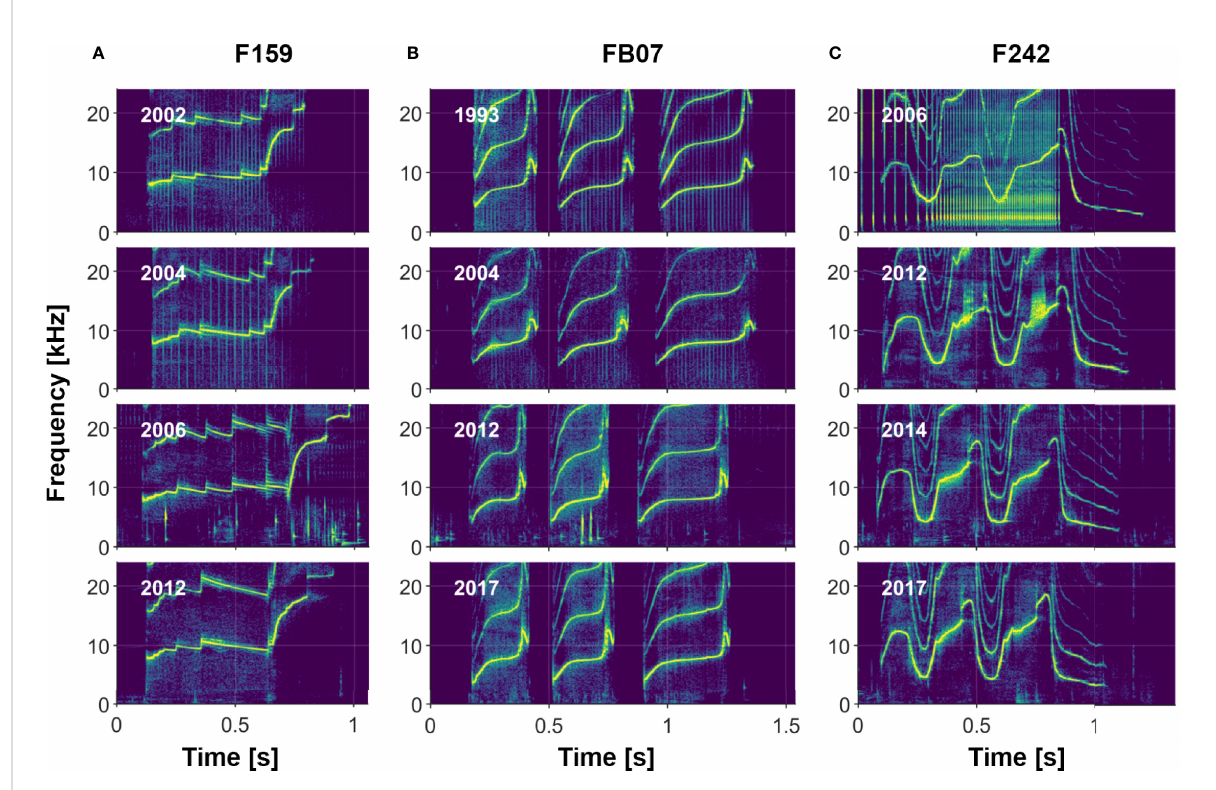
FIGURE 8 Three examples of individuals recorded across 10 or more years, illustrating signature whistle stability. (A) Female F159, who produces a single-loop whistle; (B) Female FB07, who produces a multi-loop disconnected whistle; and (C) Male F242, who produces a multi-loop connected